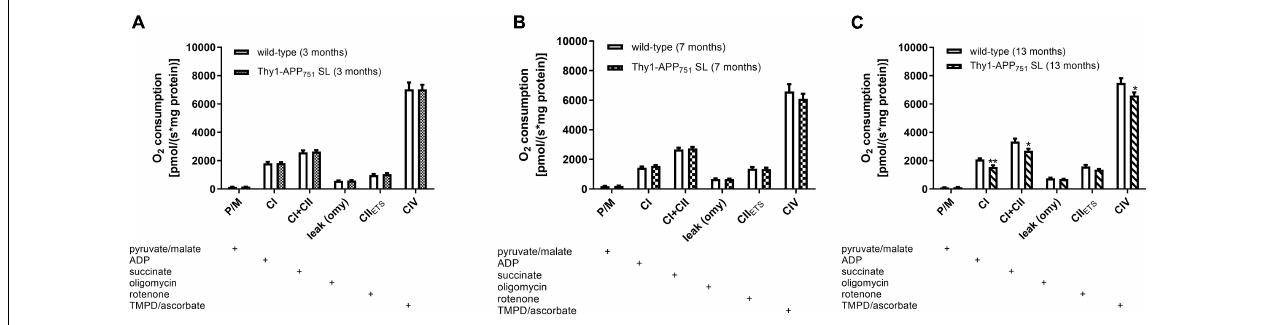
FIGURE 3 | Mitochondrial Respiration in isolated brain mitochondria from 3 (A) , 7 (B) , and 13 (C) months old Thy1-APP 751 SL mice compared to wild-type control animals of the same age; the addition of a substance into the oxygraph chamber is indicated with a plus sign; n = 10; mean ± SEM and t -test against wild-type mice of the same age with * p < 0.05 and ** p < 0.01. TABLE 2 | Basal ATP- and MMP-levels in dissociated brain cells of 3, 7, and 13 months old Thy1-APP 751 SL mice compared to wild-type (wt) control animals of the same age.